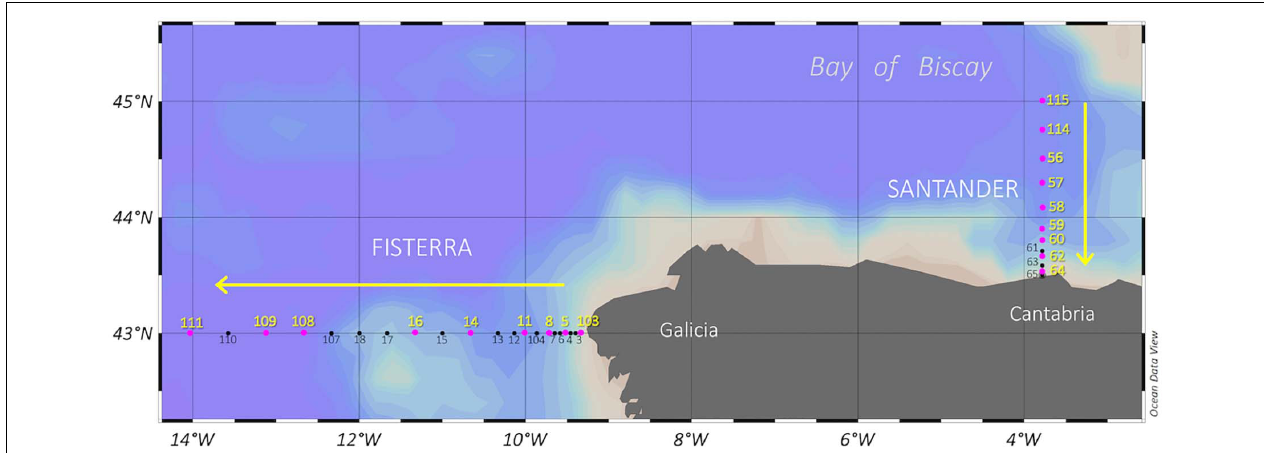
FIGURE 1 | Sampling stations during MODUPLAN cruise along Fisterra and Santander sections, off Galicia coast and in the Bay of Biscay, respectively, off the NW Iberian Peninsula. The hidrographic parameters were determined in all stations (black dots), while pink dots indicate biological stations where, additionally, prokaryotic community composition and DOM were characterized. Fisterra transect took place from August 04, 2014 to August 12, 2014, while Santander transect took place from August 14, 2014 to August 21, 2014. Arrows indicate sampling